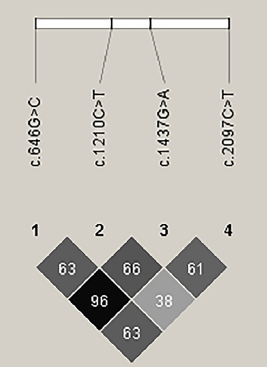
Figure 5. Linkage disequilibrium estimated among CAST variations in Sonid sheep. 1: c.646G>C, 2: